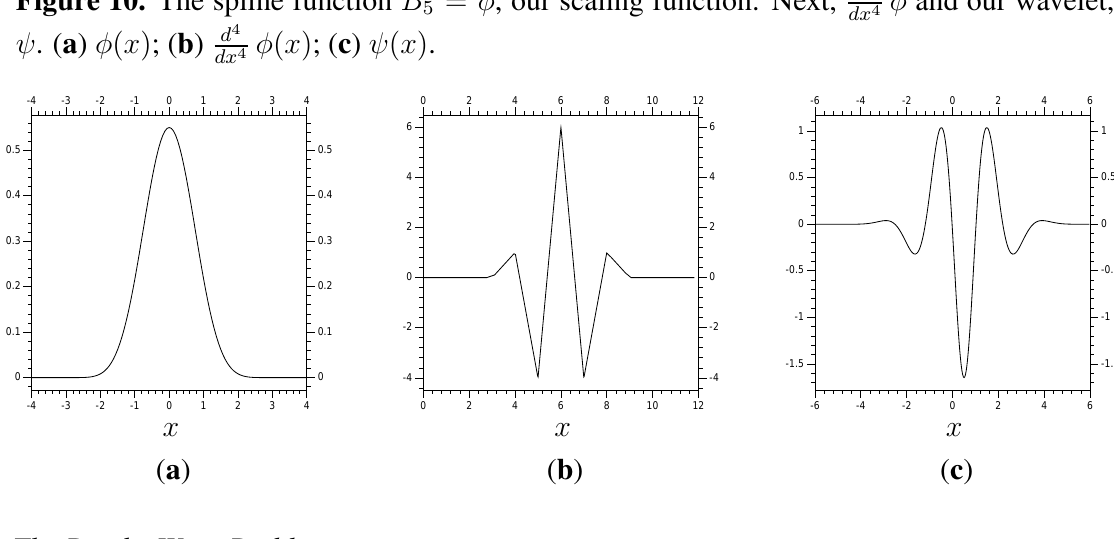
Figure 10. The spline function B